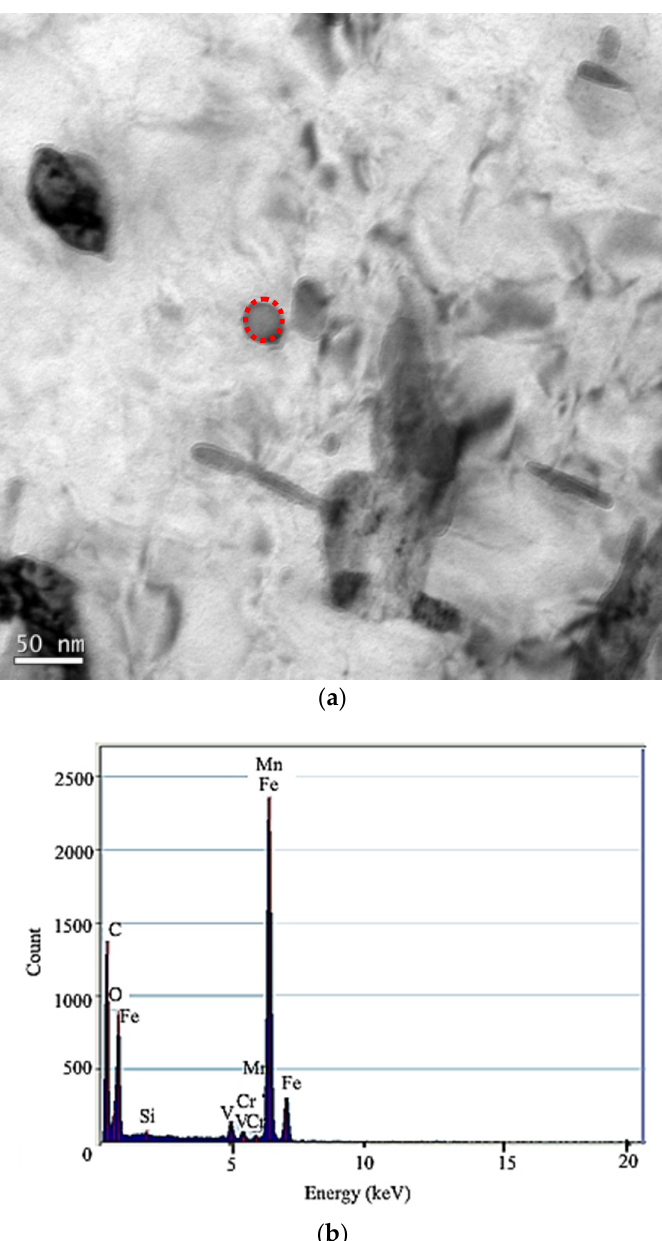
Figure 6. ( a ) TEM image of the secondary phase in 50CrVA-S2# and ( b ) the corresponding EDS analysis.